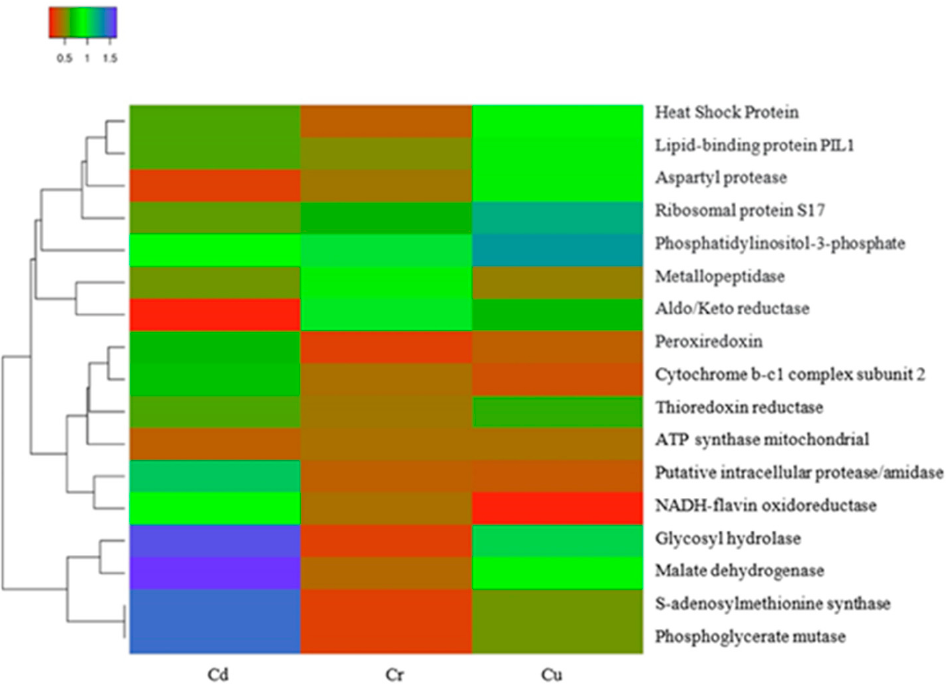
Figure 15 . Heatmap presenting most highly differentially expressed proteins in the presence of heavy metals. Proteomic profiling was performed in the presence of metal ions, namely Cd, Cr, and Cu, shown in the columns.